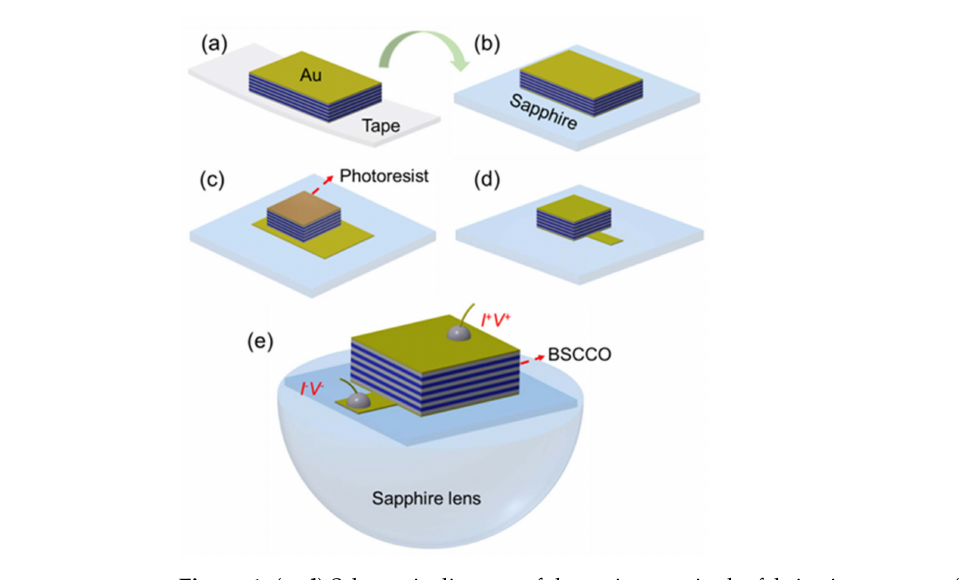
Figure 1. ( a – d ) Schematic diagram of the main steps in the fabrication process. ( e ) Schematic view of the final BSCCO stack mounted on a sapphire